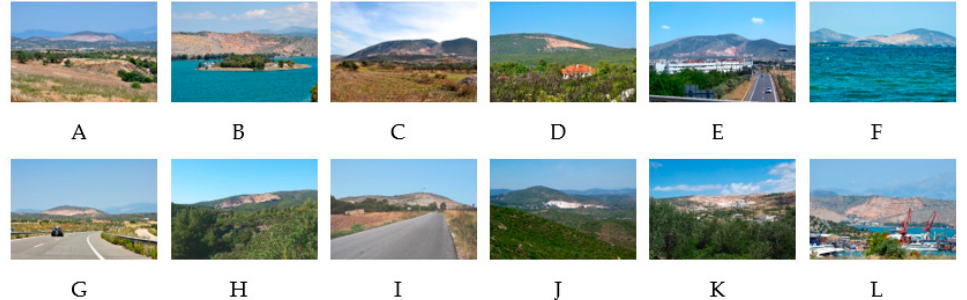
Figure 1. The 12 mining landscape photographs that were used as visual stimuli for the eye tracking experiment. The characteristics of these landscapes are different so as for the represented landscapes to be substantially differentiated. Photographs ( A , C ) represent mixed agricultural/mining landscapes; ( B , F ) are mining landscapes dominated by the water element; ( D , H , J ) represent mixed forest/mining landscapes; ( E , G , I , K , L ) are mining landscapes including artificial elements.